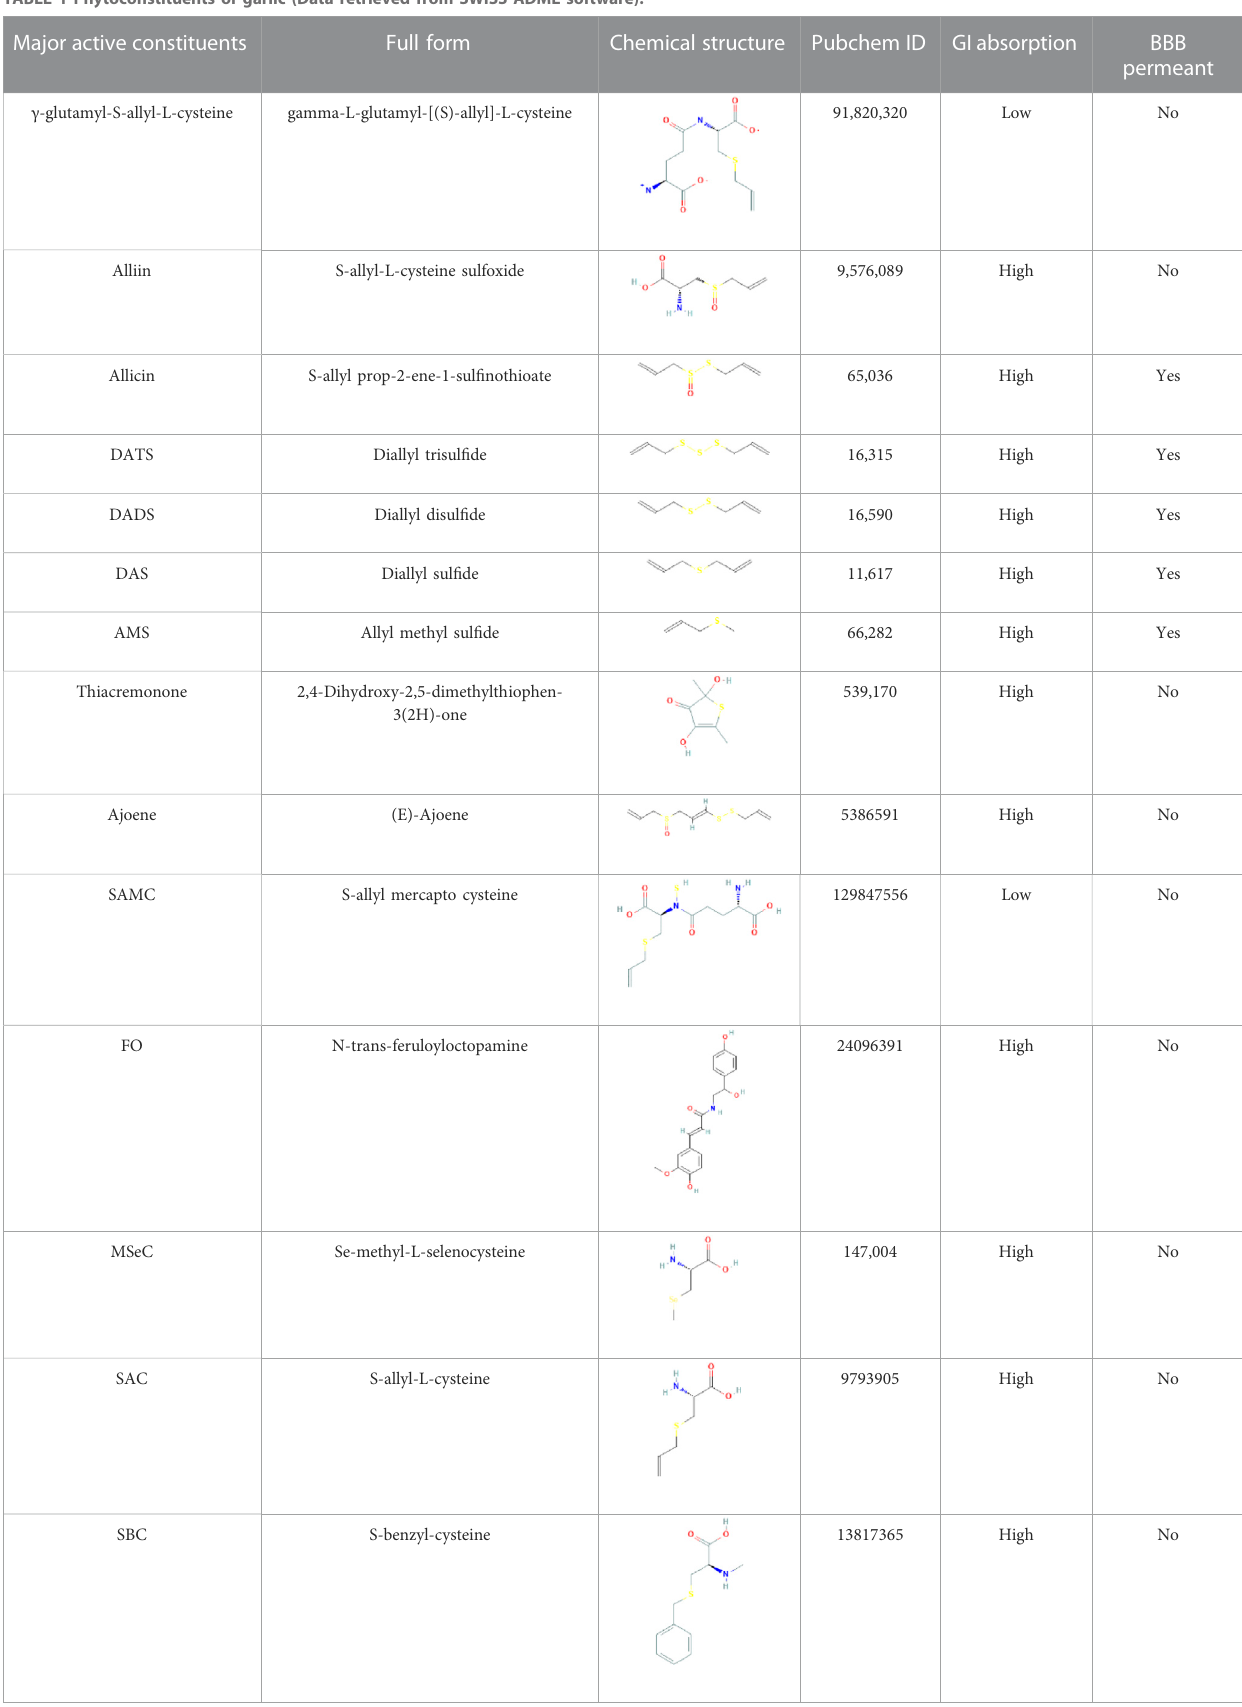
TABLE 1 Phytoconstituents of garlic (Data retrieved from SWISS ADME